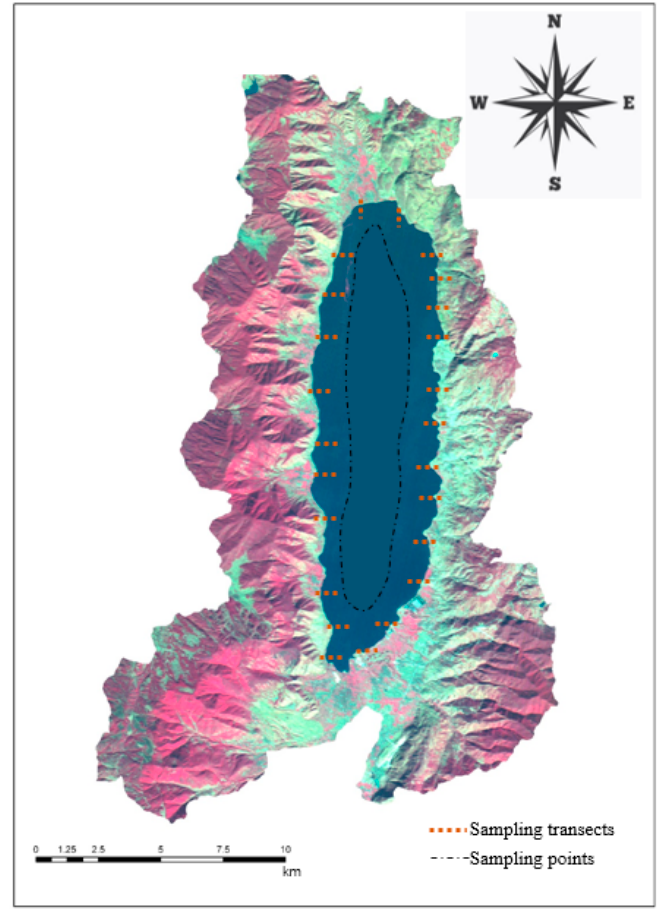
Figure 1. Sampling design of the aquatic plants in Chenghai Lake.